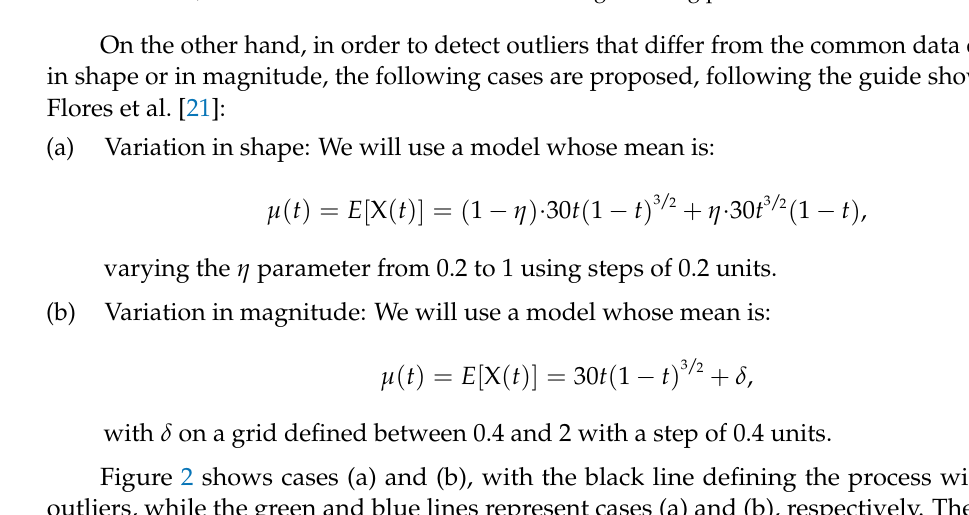
Figure 1. Functional means for the two simulated processes [21]. The mean of the first model is shown in black, while the mean of the anomalous data-generating process is shown in red.